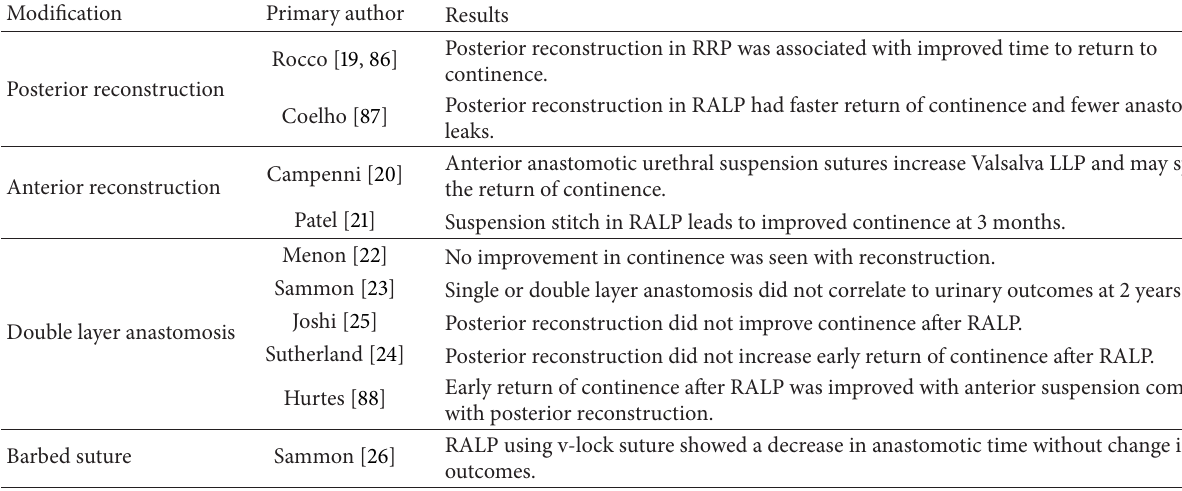
Table 3: Urethrovesical